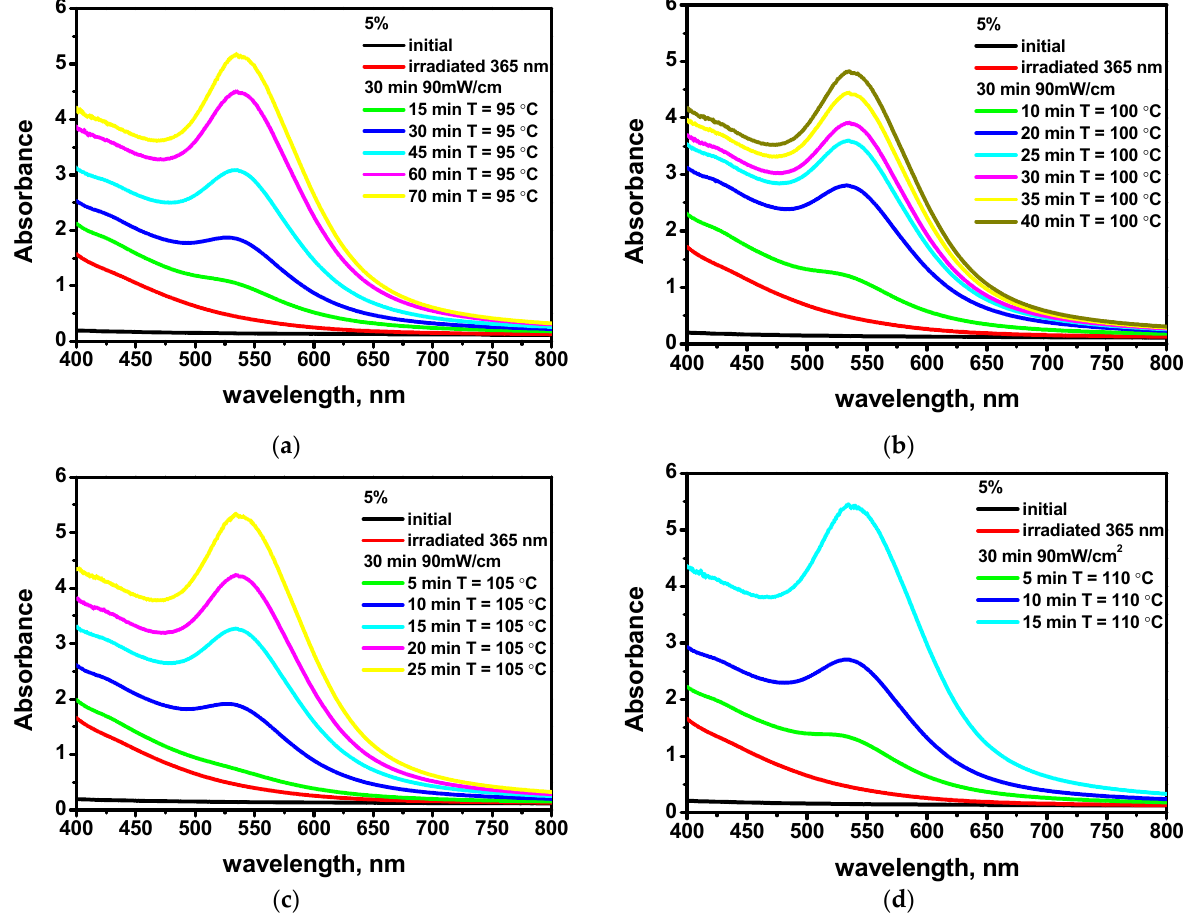
Figure 2. Absorbance of samples of polystyrene + 5 wt % (Ph 3 P)Au( n -Bu): initial, after irradiation and after further heating at temperatures of ( a ) 95 °C, ( b ) 100 °C, ( c ) 105 °C, and ( d ) 110 °C.